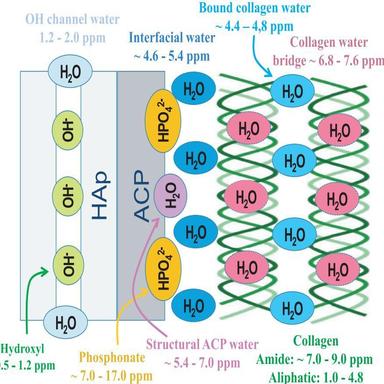
Schematic view of the main hydrogenated dentin species with their 1H chemical shift range.